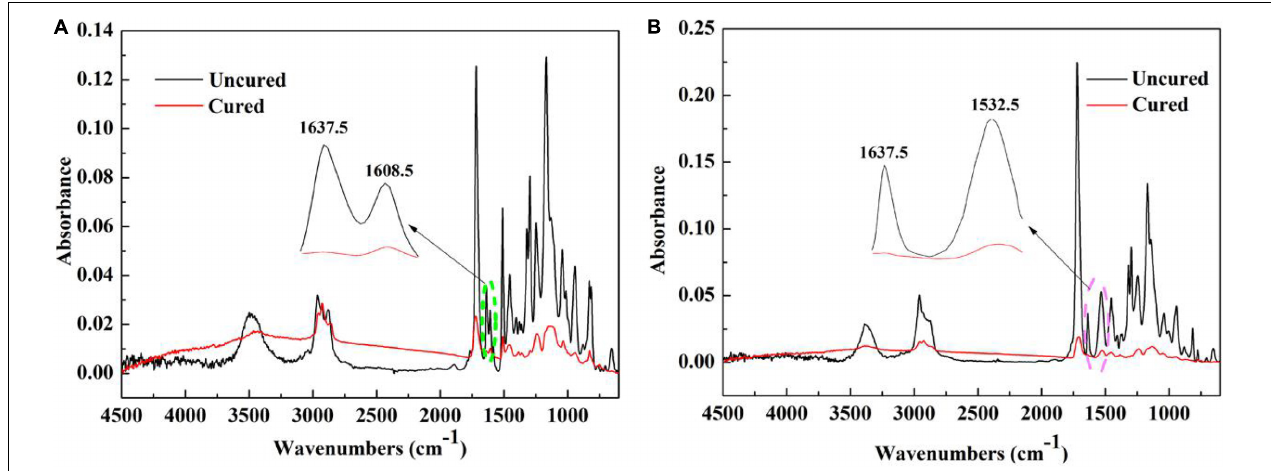
FIGURE 1 | Mid-infrared spectroscopy of uncured and cured pure resin. (A) Bis-GMA/TEGDMA, (B) UDMA/TEGDMA.